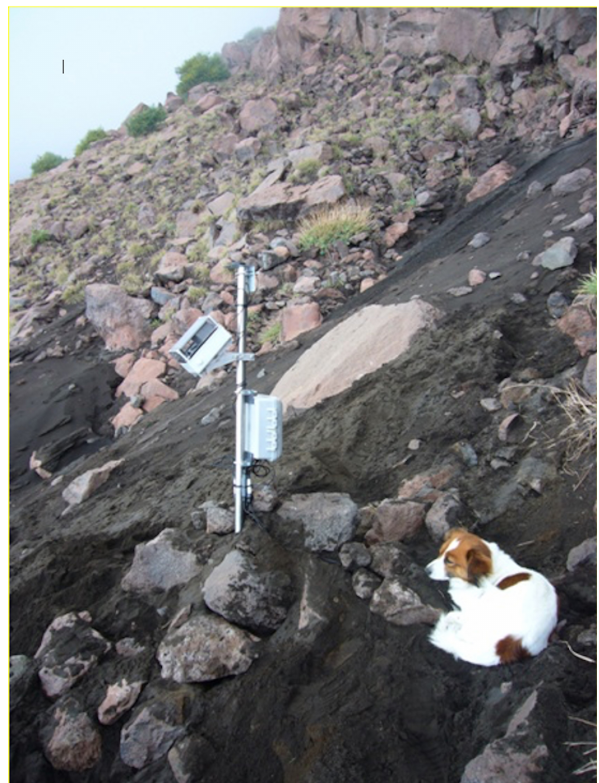
Figure 2. A typical mounting arrangement for a 3-depths LTF tem- perature probe.